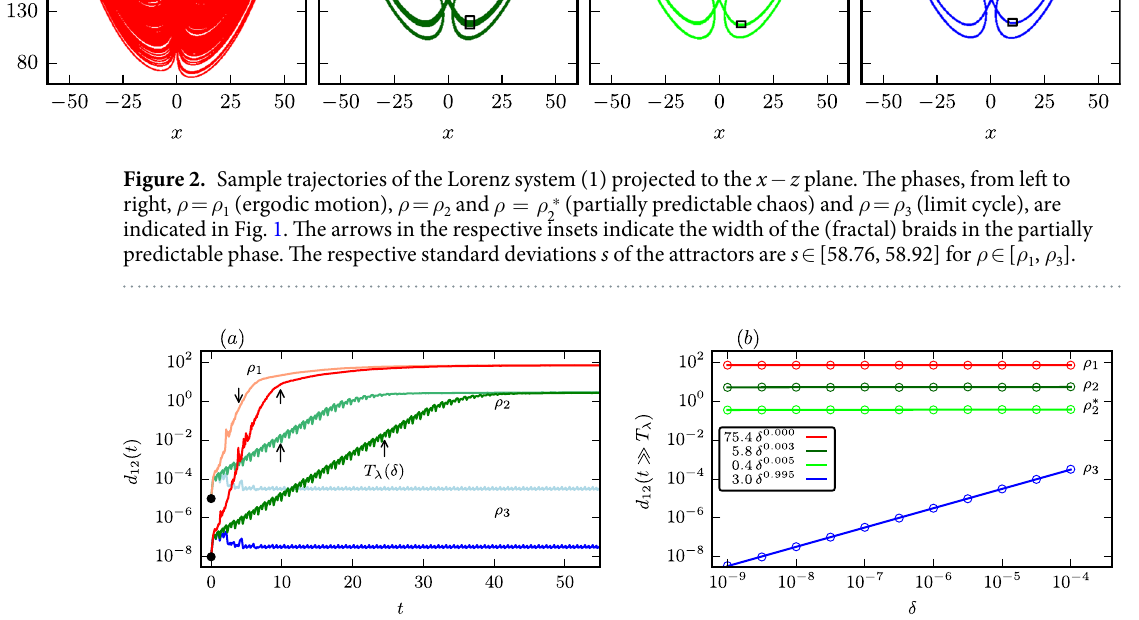
( ρ > ρ C , blue), is governed by PPC. A spontaneous symmetry-breaking bifurcation 16 (SSB) is additionally shown. Chaos-chaos transitions involving phase space explosions, like the one occurring at ρ p between partially predict- able and strong chaos (which is in part intermittent 17 ), have been studied previously in the context of quadratic maps 18 and driven Josephson junctions 10, 11 . They are due to the collision of an unstable manifold with the attract- ing chaotic set, an interior crisis 18 which is a typical example of a global bifurcation 6 . and ( c ) PPC, and ( d ) laminar flow. Partially predictable chaos is at times difficult to distinguish visually from lam- inar flow (compare Fig. 2(c,d)), we hence provide the respective blow-ups in the insets. The partially predictable chaotic attractors can be thought as fractally broadened limit cycles, viz as braids. The maximal Lyapunov exponent 19 λ m presented in Fig. 1(b) has been evaluated by extracting the initial slope of the logarithmic distance 〈 ln| x 1 ( t ) − x 2 ( t )| 〉 of two trajectories, as averaged over 10 4 pairs with initial distances of δ = 10 − 8 , when plotted as a function of time. | … | denotes here the Euclidean distance and 〈 … 〉 the average over